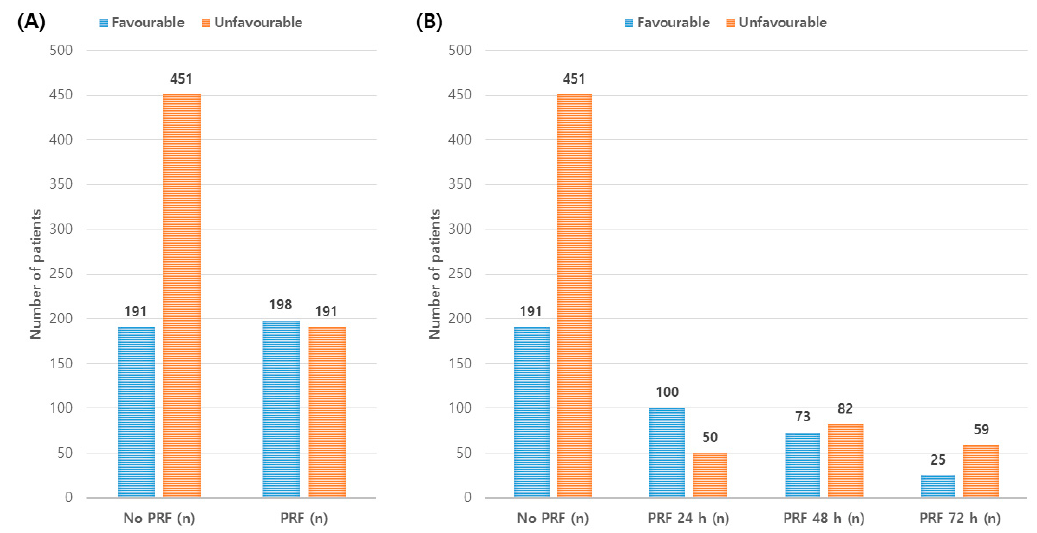
Figure 2. Association of neurological outcomes at 6 months with post-rewarming fever and timing of post-rewarming fever. ( A ) Patients with post-rewarming fever (PRF) had higher favorable neurologic outcomes than those without PRF ( p < 0.001). ( B ) Neurological outcomes were di ff erent between PRF onset timings ( p < 0.001). Patients who developed PRF within the 24 h, 24–48 h, and 48–72 h had 66.7%, 47.1%, and 29.8% favorable neurologic outcomes, respectively. Table 4. Multivariate logistic regression analyses of post-rewarming fever and onset-time of post- rewarming fever for unfavorable neurologic outcome at 6 months after cardiac arrest.